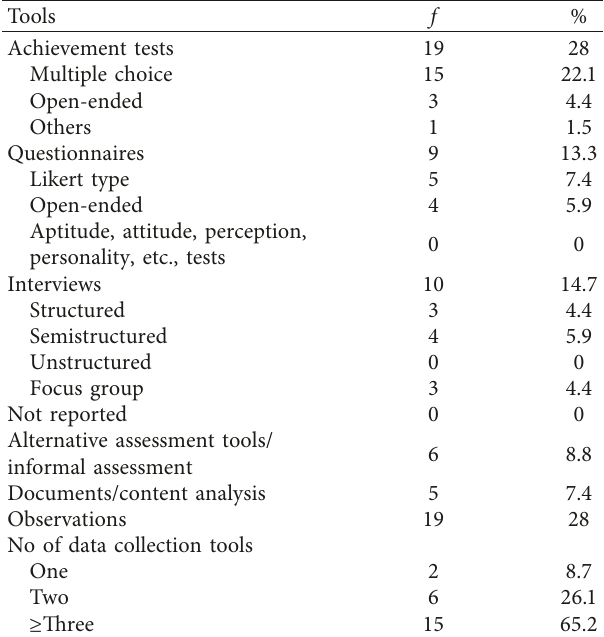
Table 7: Types of data collection tools in IBL studies in Ethiopia (2010 to 2021).